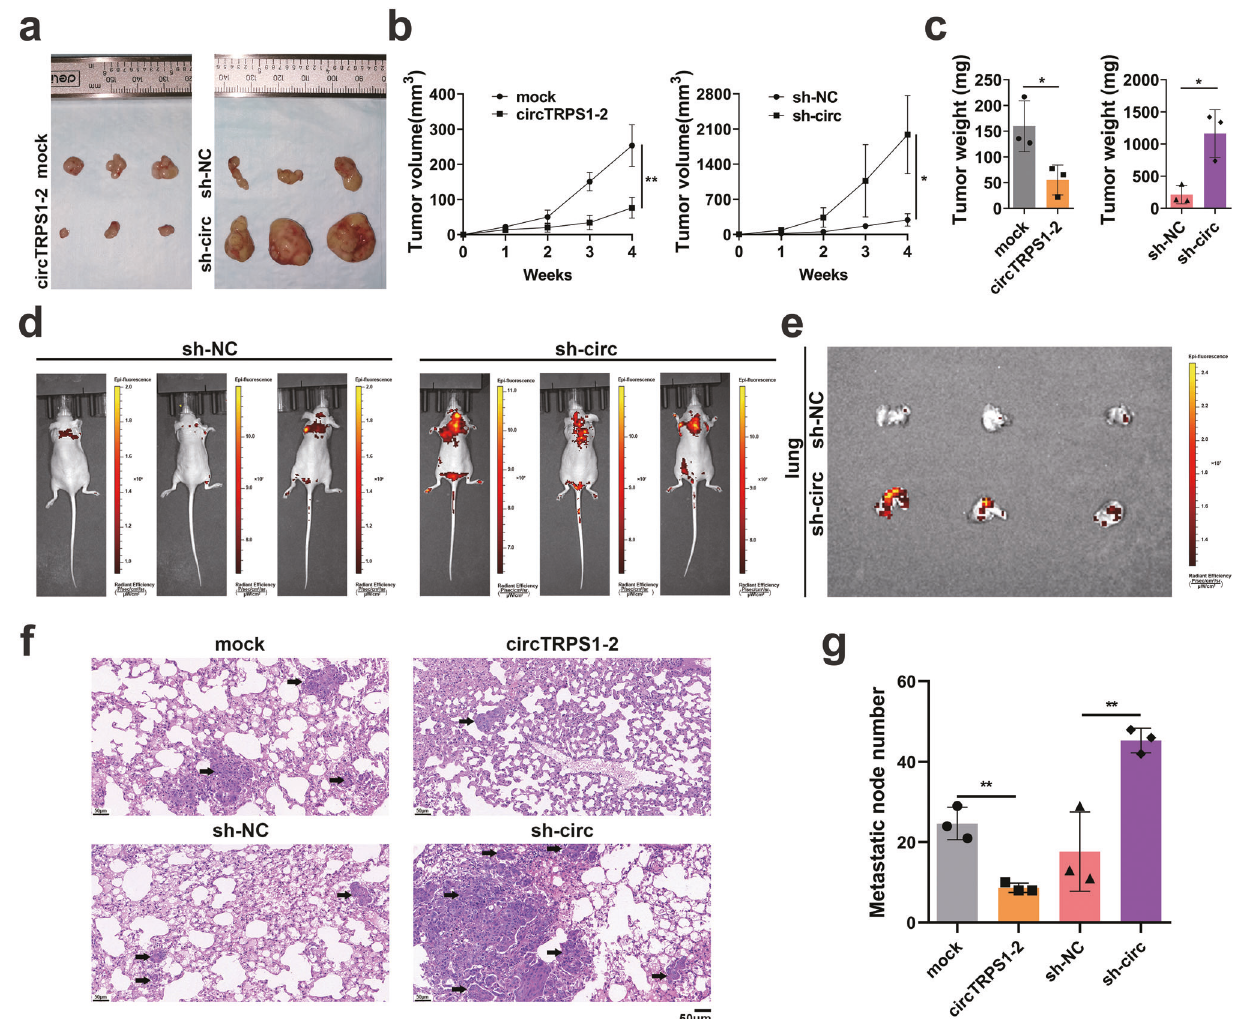
Fig. 5 CircTRPS1-2 inhibits the tumorigenesis and metastasis of ESCC in vivo. a Representative images of subcutaneous tumors from each group. b Growth curves based on weekly measurements of tumor volumes. c Tumor weights. d Numbers of super fi cial metastatic nodules in circTRPS1-2 knockdown group, based on IVIS 200 Spectrum analysis. e Representative lung metastases in circTRPS1-2 knockdown group, based on IVIS 200 Spectrum analysis. f Hematoxylin-eosin staining of lung metastatic nodules. Black arrows indicate metastatic nodule. Magni fi cation, 200×. Scale bar, 50 µm. g Total number of metastatic nodules. Data are mean ± SD ( n = 3 biologically independent samples). * P < 0.05, ** P < 0.01. circTRPS1-2, circTRPS1-2 overexpression lentivirus; IVIS, in vivo imaging system; mock and sh-NC, negative control lentivirus; sh-circ, circTRPS1-2 shRNA interference how ESCC begins and progresses, and to exploit the RNA as a novel prognostic marker.